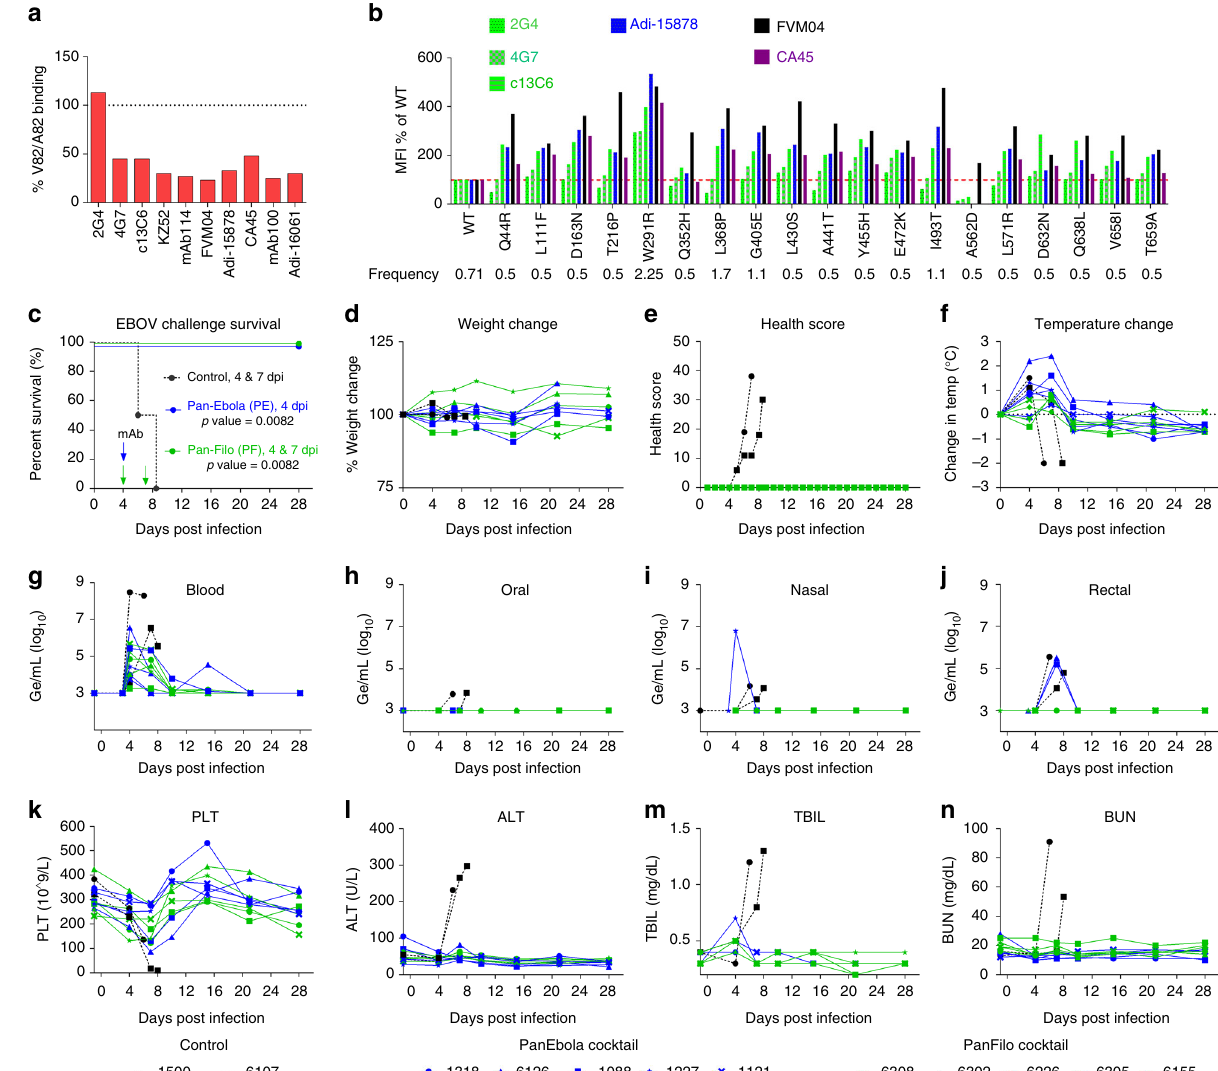
Fig. 2 Ef fi cacy of the PE and PF cocktails against EBOV Makona. a Binding of the indicated antibodies to V82 GP variant as percentage of binding to A82 Makona GP. b Relative binding of the indicated mAbs to Makona quasispecies compared to wt. c – f Ef fi cacy of PE ( n = 5) and PF ( n = 5) cocktails in NHP model of EBOV Makona infection. g – j Viral loads in blood, as well as oral, nasal, and rectal swabs. k – n Select hematology and blood chemistry data at various times post challenge. PLT platelets, ALT alanine transaminase, TBIL total bilirubin, BUN blood urea nitrogen. Statistical analysis of survival was performed by log-rank